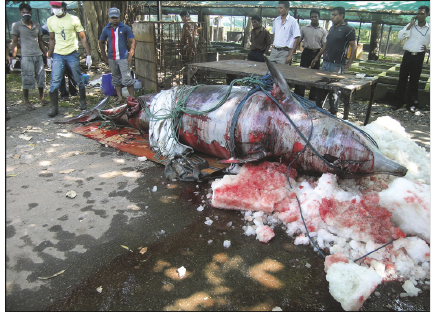
Figure 4: Cuvier’s beaked